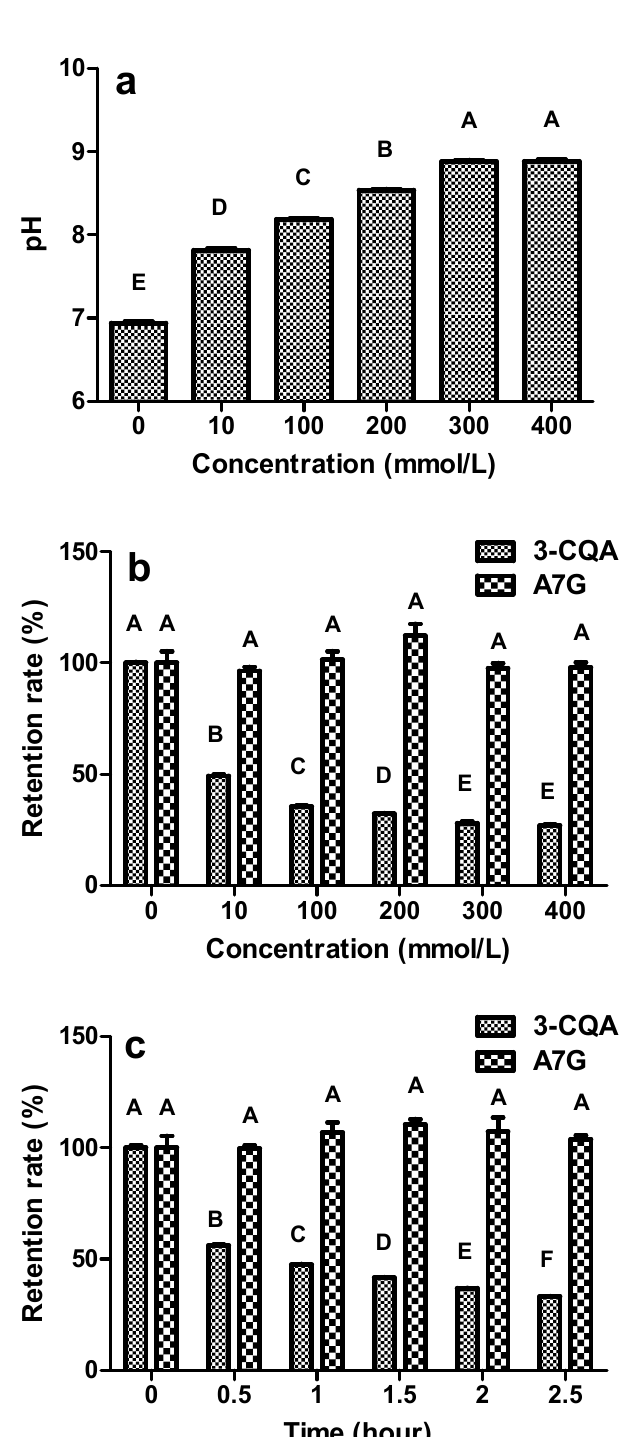
Figure 2. The e ff ect of basic conditions on the retention rates of 3-CQA and A7G. Results using: ( a ) pH values of ammonium hydrogen carbonate, ( b ) various concentrations of ammonium hydrogen carbonate ranging from 0 to 400 mmol / L, and ( c ) time from 0 to 2.5 h. Means indicated by di ff erent letters di ff ered significantly with a value of p < 0.01.